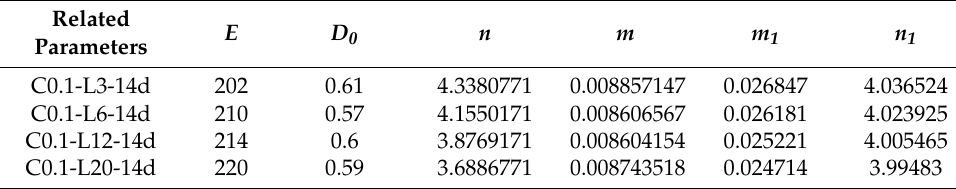
Table 7. Related parameters of the BFRCS subjected to curing for 14 d.